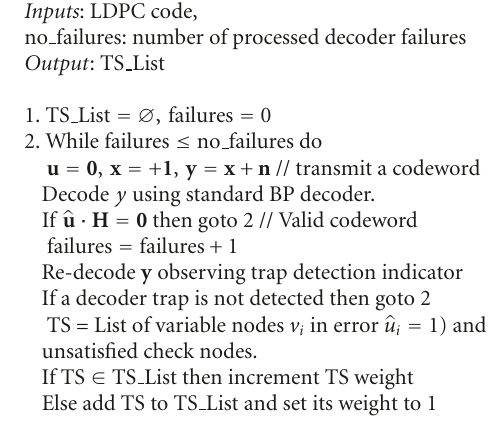
Algorithm 2: Trapping sets identification